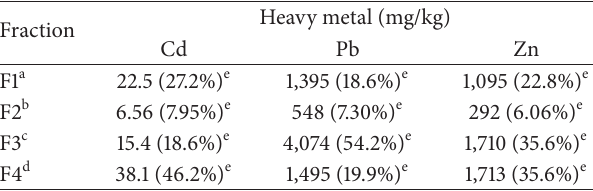
Table 4: Results of sequential extraction of Cd, Pb, and Zn in soil